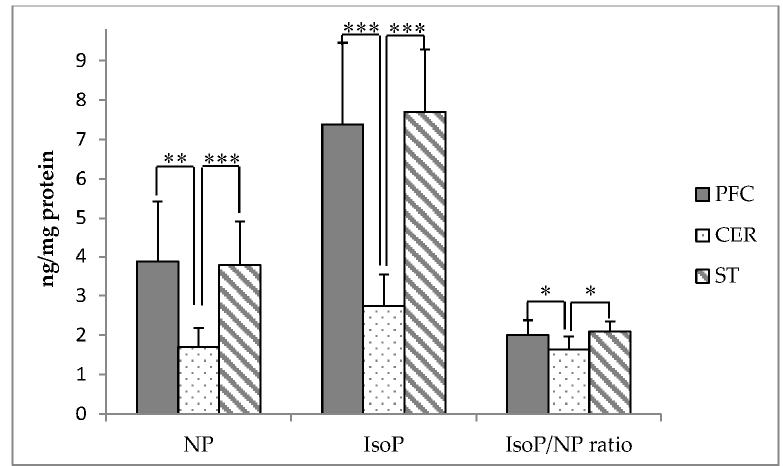
Figure 3. Neuroprostane (NP) and isoprostane (IsoP) concentrations (ng/mg protein) in the prefrontal cortex (PFC), cerebellum (CER), and striatum (ST) of adult rhesus macaques ( n = 9). Asterisks indicate significant differences between brain regions according to one-way ANOVA followed by Tukey’s HSD